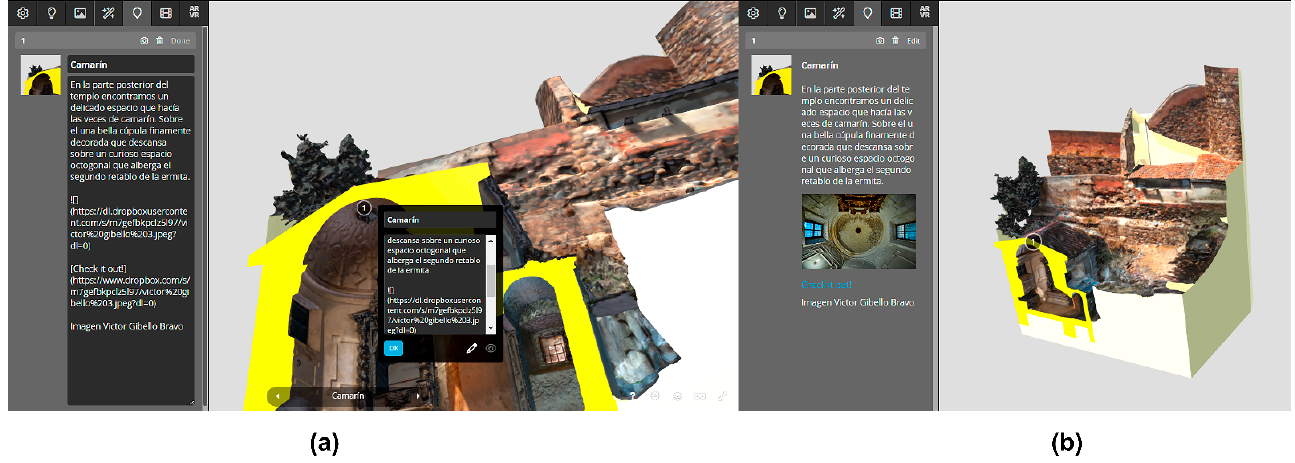
Figure 20. ( a ) Editing of contents within the model. ( b ) View of contents: detailed photograph and link to other web pages.